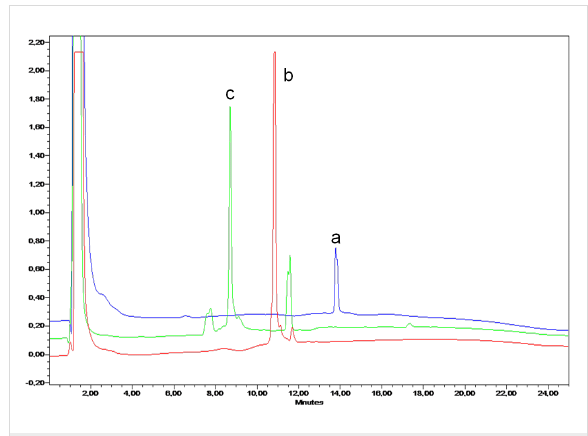
Figure 2: RP-HPLC profile of the one-pot synthesis of hGC 11 (linear A–B gradient: 5 to 100% B in 20 min, λ = 214 nm); (a, blue) cyclode- capeptide precursor 9 ; (b, red) crude mixture of intermediate product 10 ; (c, green) corresponds to crude mixture after TCC and TEC ( 11